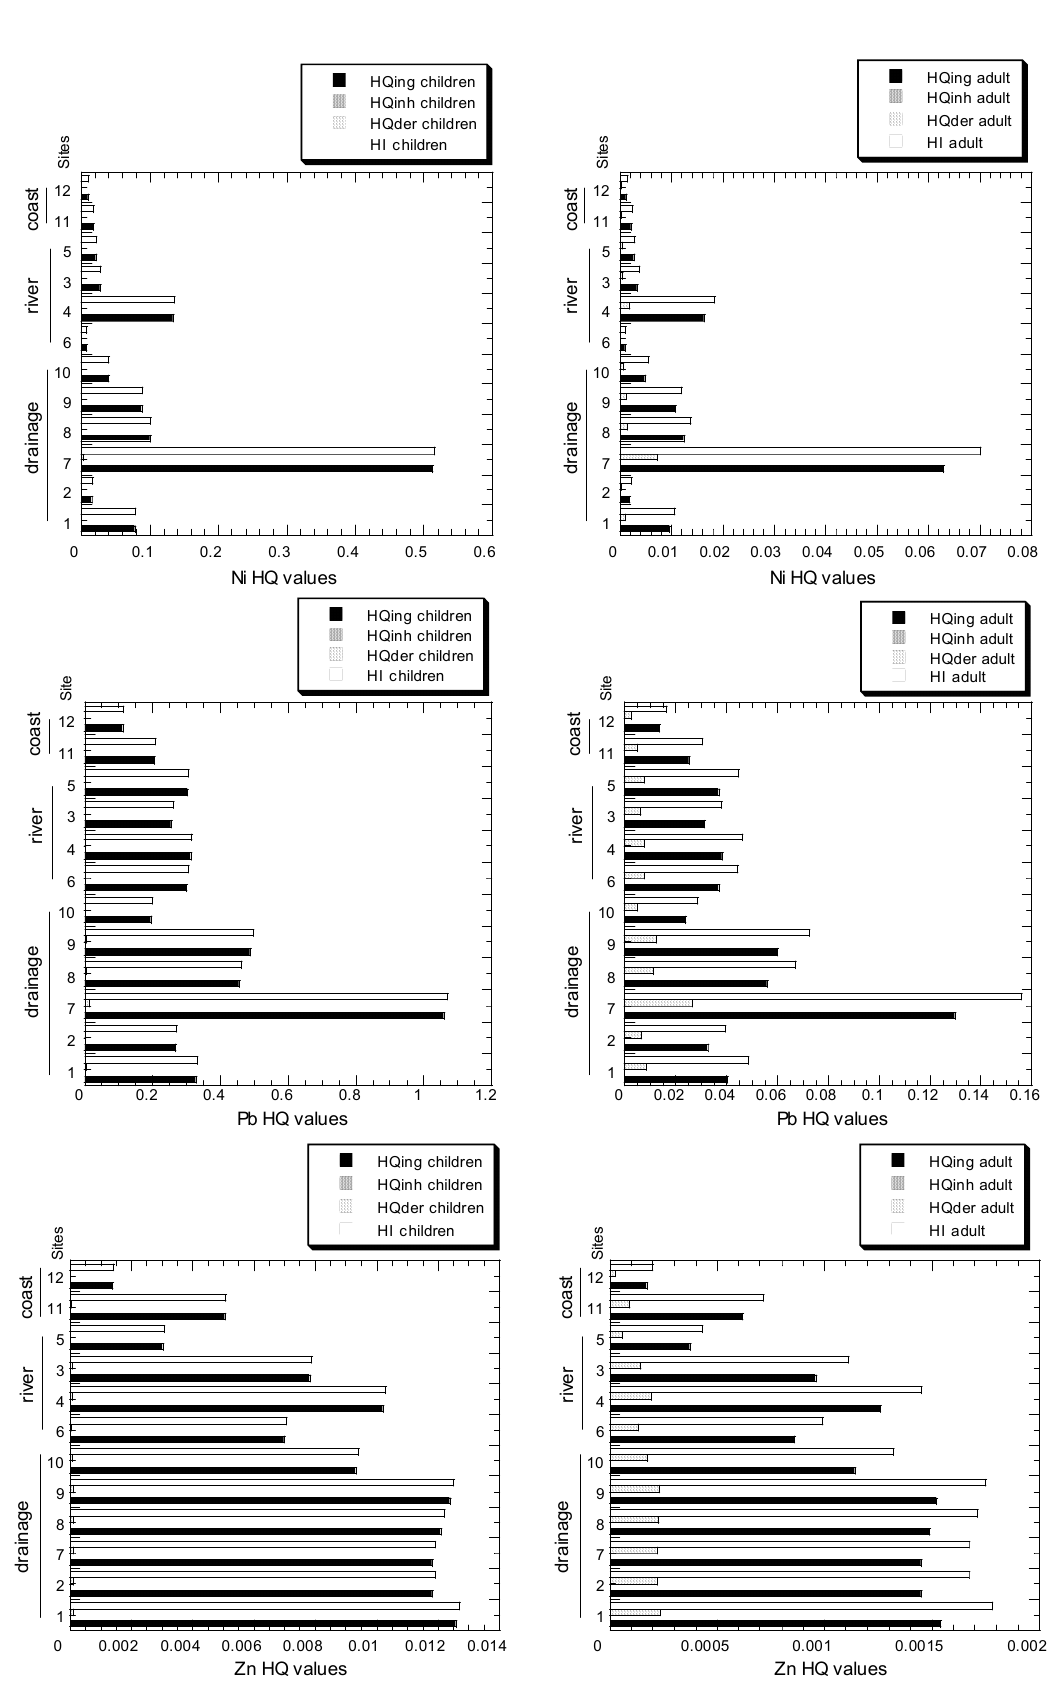
Figure 8. Comparisons of the values of the hazard quotient (HQ) and hazard index (HI) in the three exposure routes of Cd, Ni, Cu, Pb, and Zn in children (C) and adults (A) from the present study.